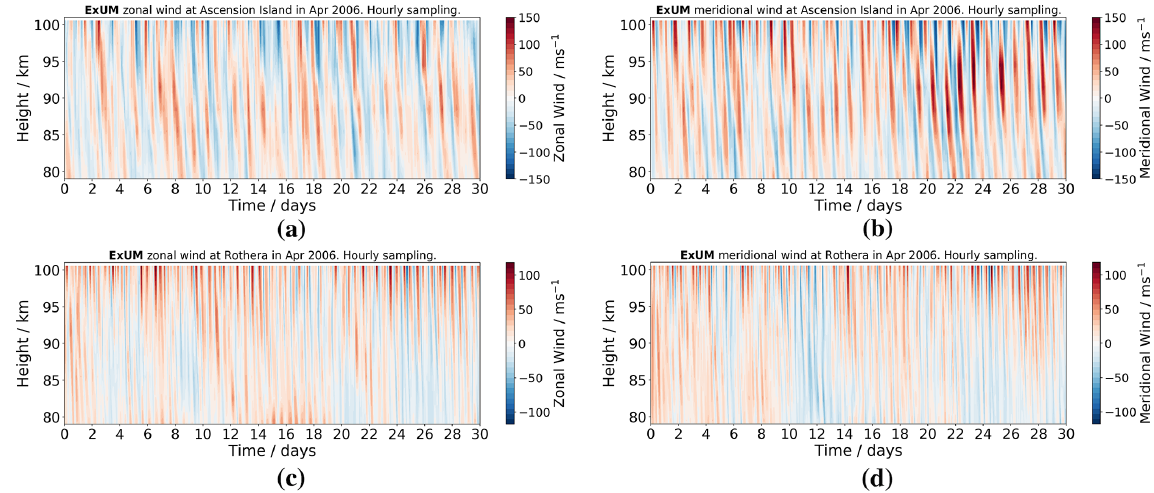
Figure 5. ExUM time–height wind contours from the 94-level model configuration in April 2006. At Ascension Island for the (a) zonal ( u ) and (b) meridional ( v ) components. Similarly at Rothera for the (c) zonal ( u ) and (d) meridional ( v )